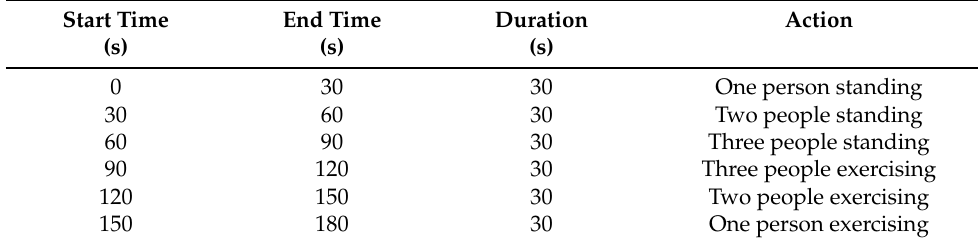
Table 1. Estimating occupancy and activity